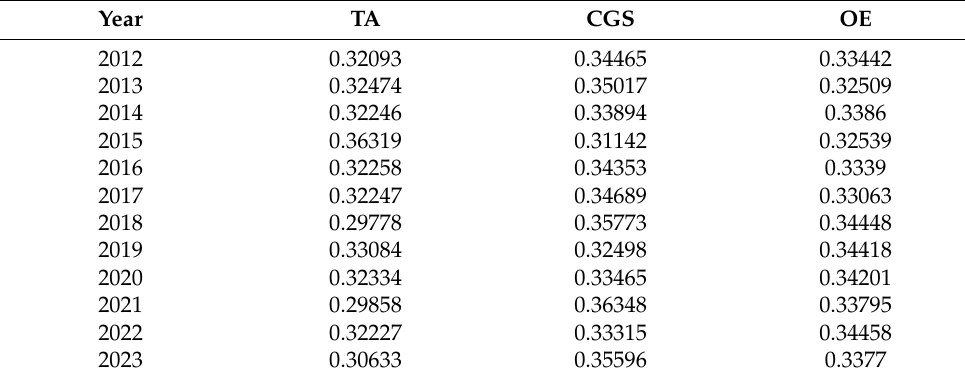
Table 7. Weight to input or output.